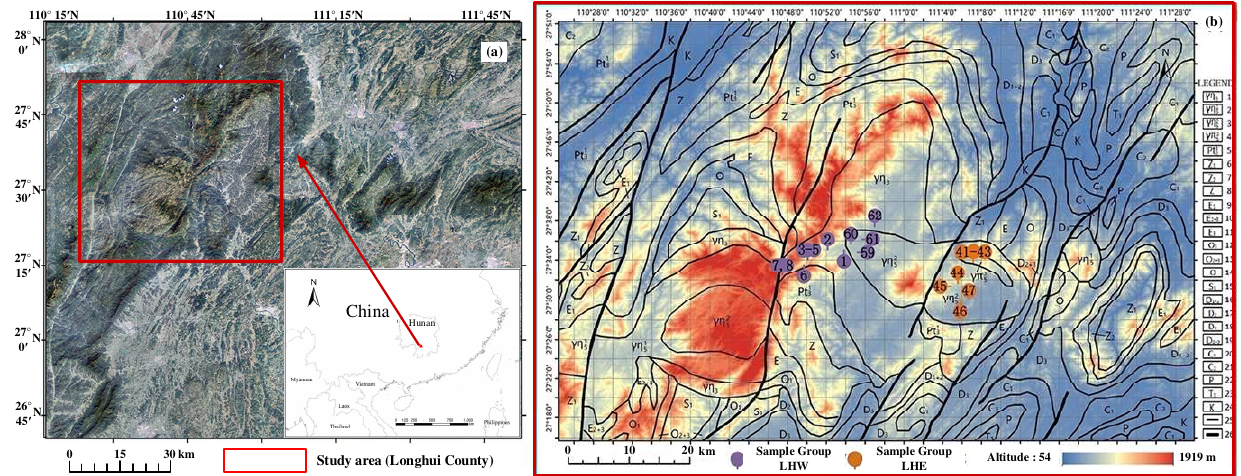
Figure 1. Geographical location of the research area and distribution of rock sampling points: ( a ) location of research area and ( b ) geological structure, lithological distribution and rock sampling points in the central area of Hunan Province, China. The samples were classified into two groups on the basis of their sampling position. Legend: 1: Silurian. 2: Triassic. 3: Jurassic. 4: Cretaceous. 5: